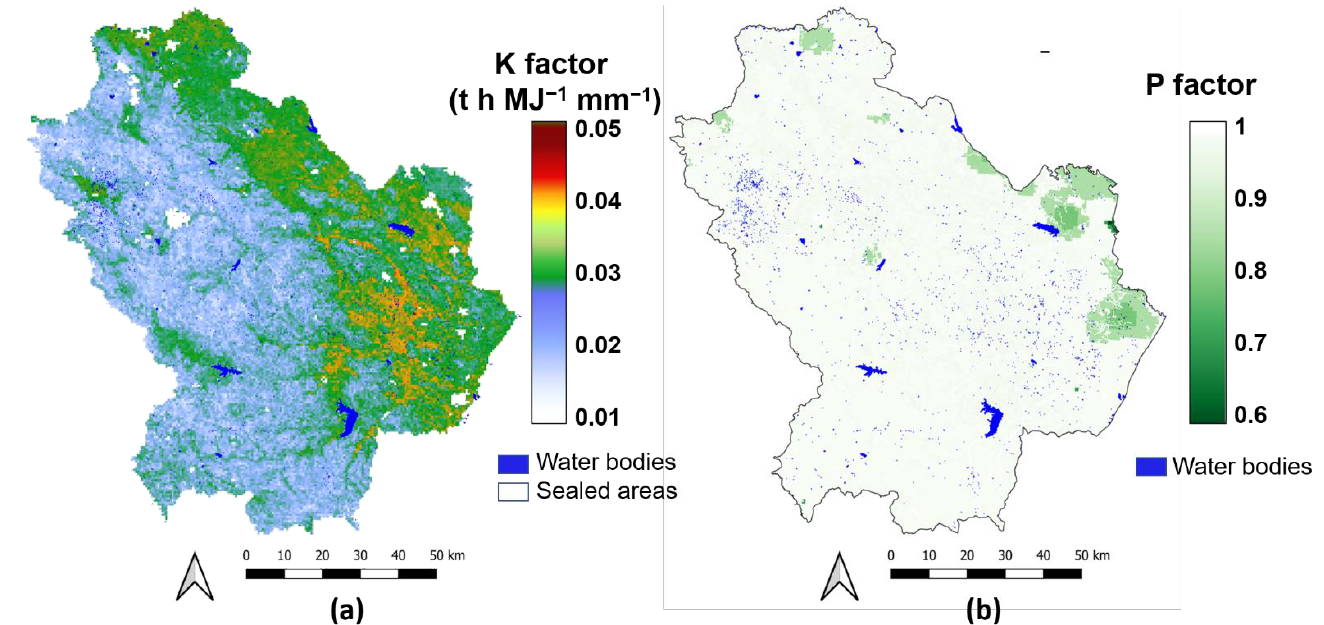
Figure 5. ( a ) Soil erodibility (K) factor values; ( b ) erosion control practice (P) factor values.